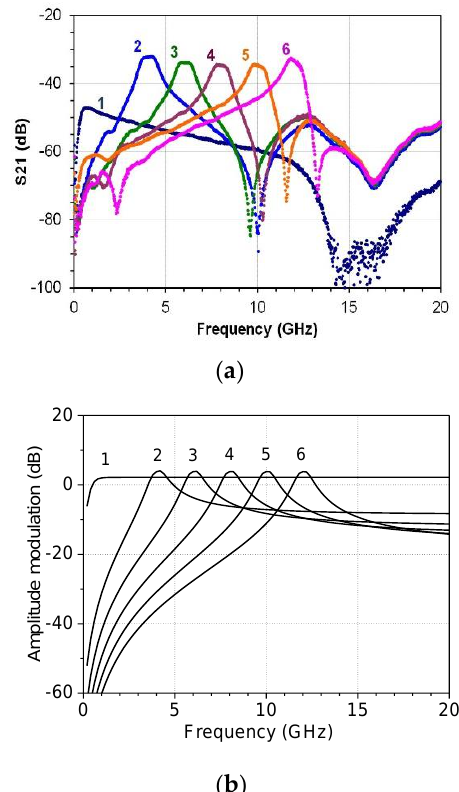
Figure 4. ( a ) Experimentally observed frequency transfer function of the demodulator for the broad- band (curve 1) and the narrowband operation modes at different detuning frequencies approximately equal to 0.25 (curve 1), 4 (2), 6 (3), 8 (4), 10 (5), and 12 GHz (6). ( b ) Theoretical simulations obtained for similar detuning of the laser wavelength from the center of the absorption line with a Lorentzian profile, a maximum absorbance of 3, and an FWHM spectral width of 0.5 GHz.